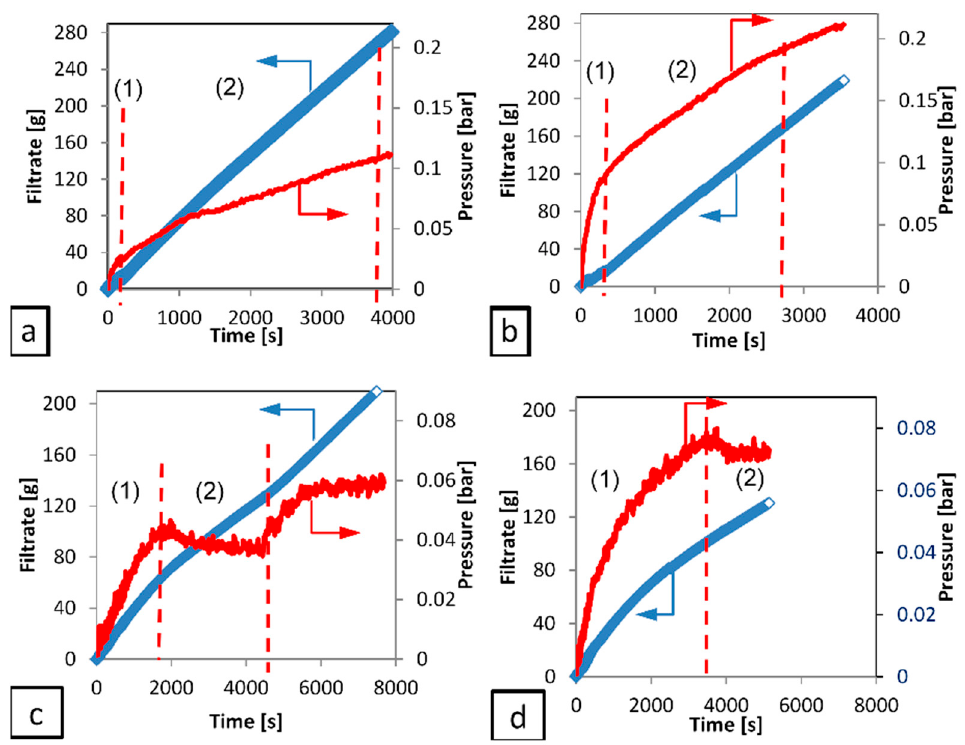
Figure 5. The two stages (1 and 2, indicated in the figures by the two dashed vertical red lines) during talc filtration, ( a ) 0.01 v / v and ( b ) 0.05 v / v feed suspension concentration and calcium carbonate filtration, ( c ) 0.09 v / v and ( d ) 0.21 v / v feed suspension concentration at 5 rpm pump speed.